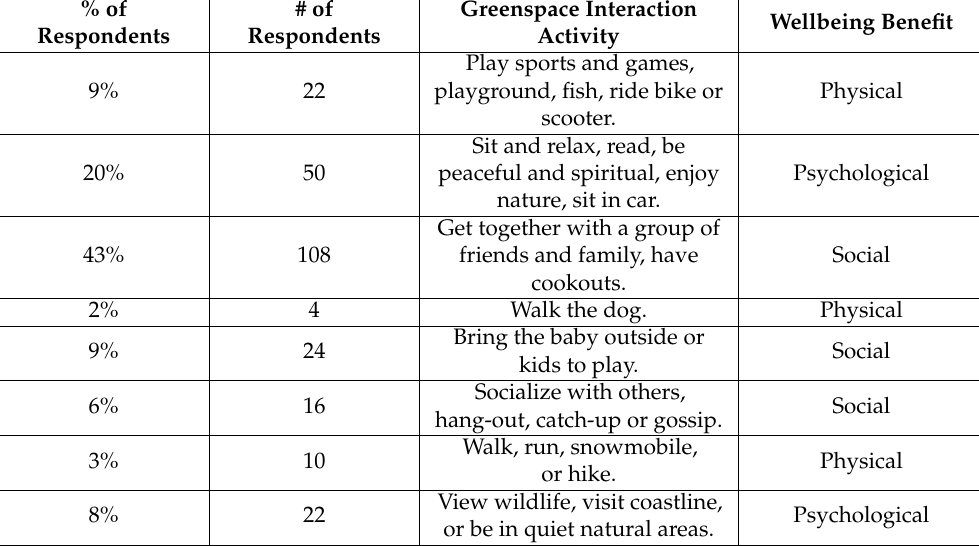
Table 5. Greenspace interaction results. Individual interactions (n = 256) provided by